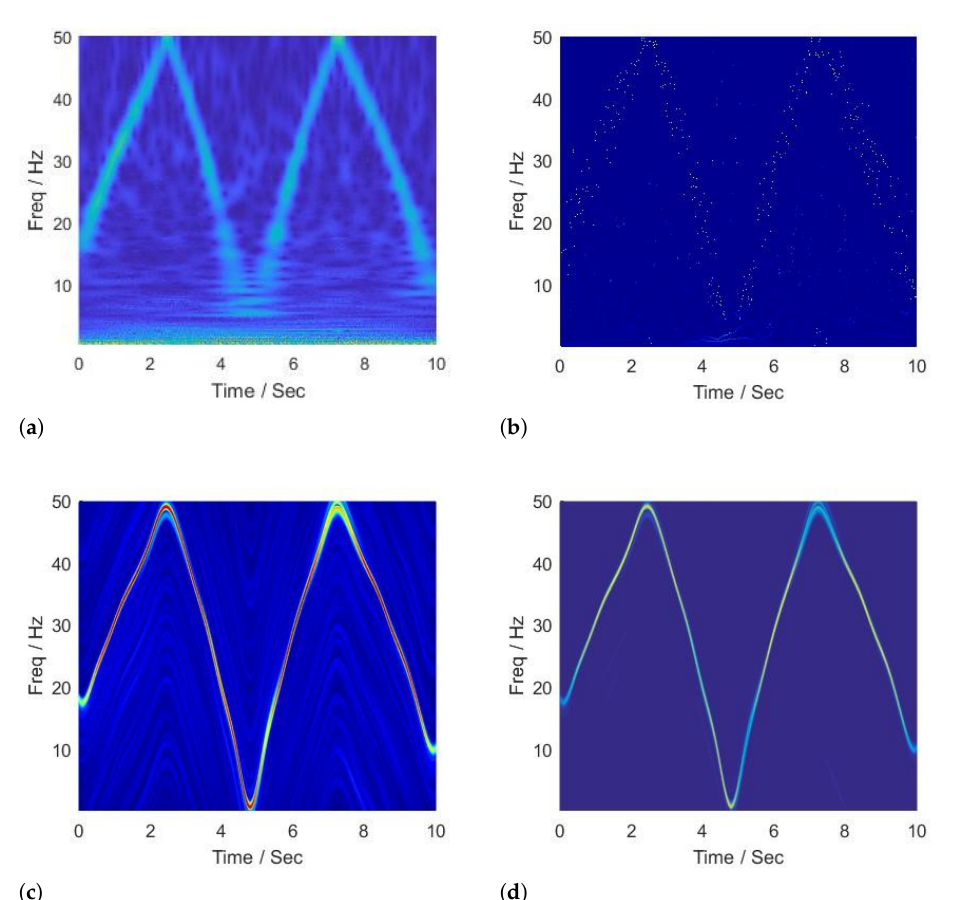
Figure 2. Time-frequency analysis of signal with instantaneous frequency in Equation (19) by ( a ) CWT, ( b ) HHT, ( c ) SCT, and ( d )